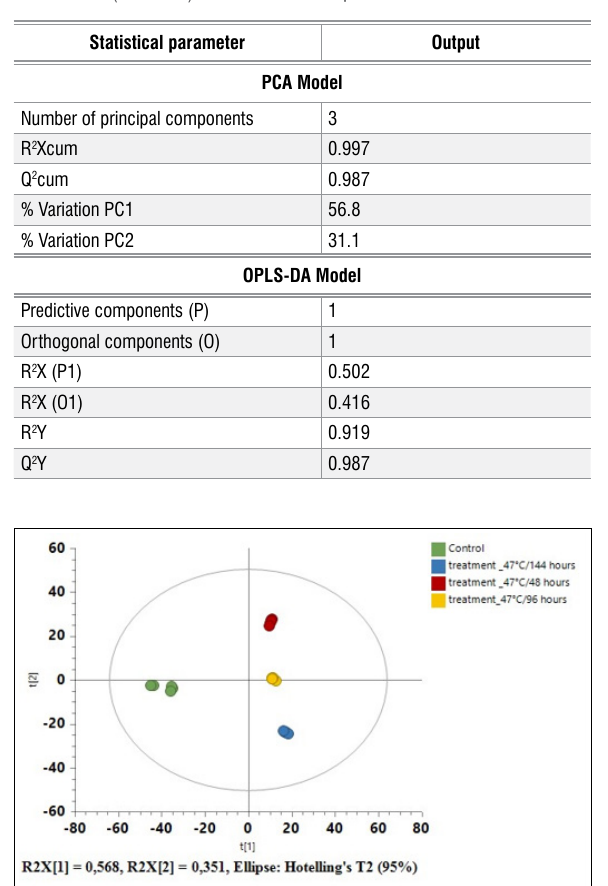
Centre-scaled principal components analysis (PCA) and orthogonal projections to latent structures discriminant analysis